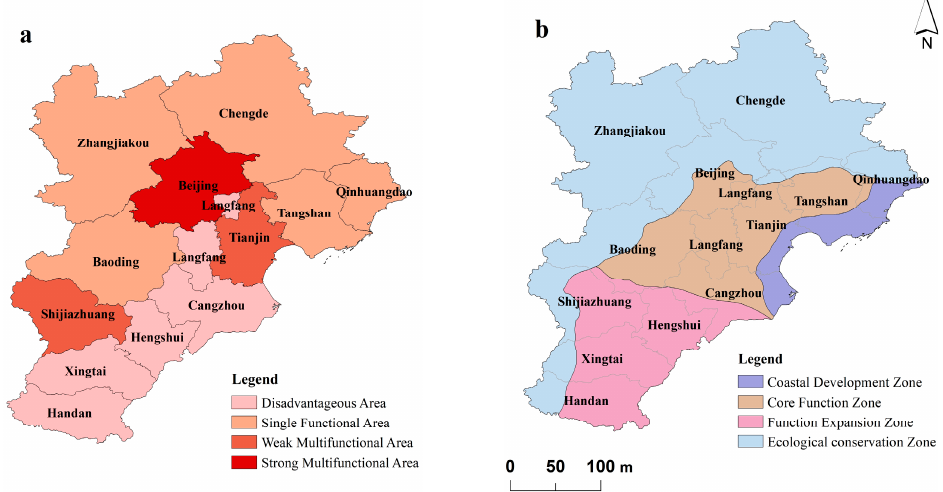
Figure 12. ( a ) The production-living-ecology land use multifunctionality assessment result in 2015; ( b ) the spatial planning of the Beijing-Tianjin-Hebei region.